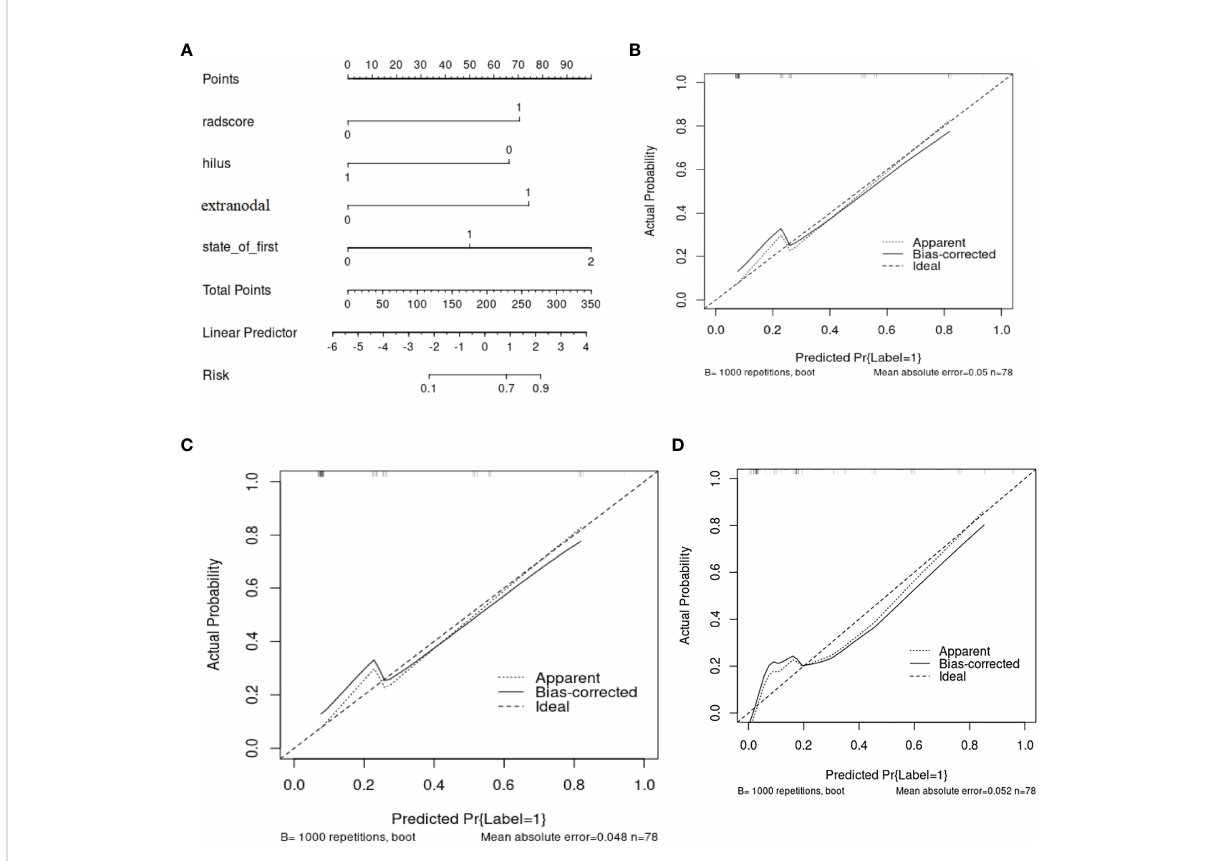
FIGURE 5 (A) The nomogram base on the model 3 and the calibration curve from (B) the training cohorts, (C) the internal validation cohort, (D) the internal validation